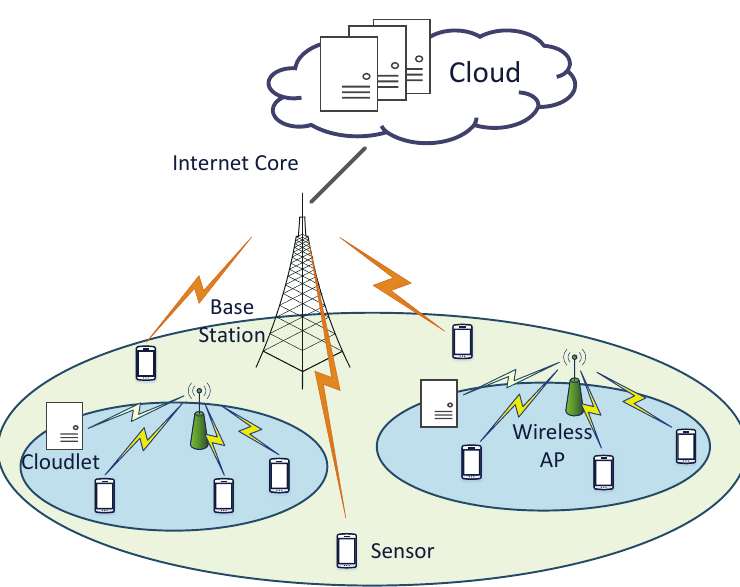
Figure 1. Cloud-assisted cloudlet-based mobile edge